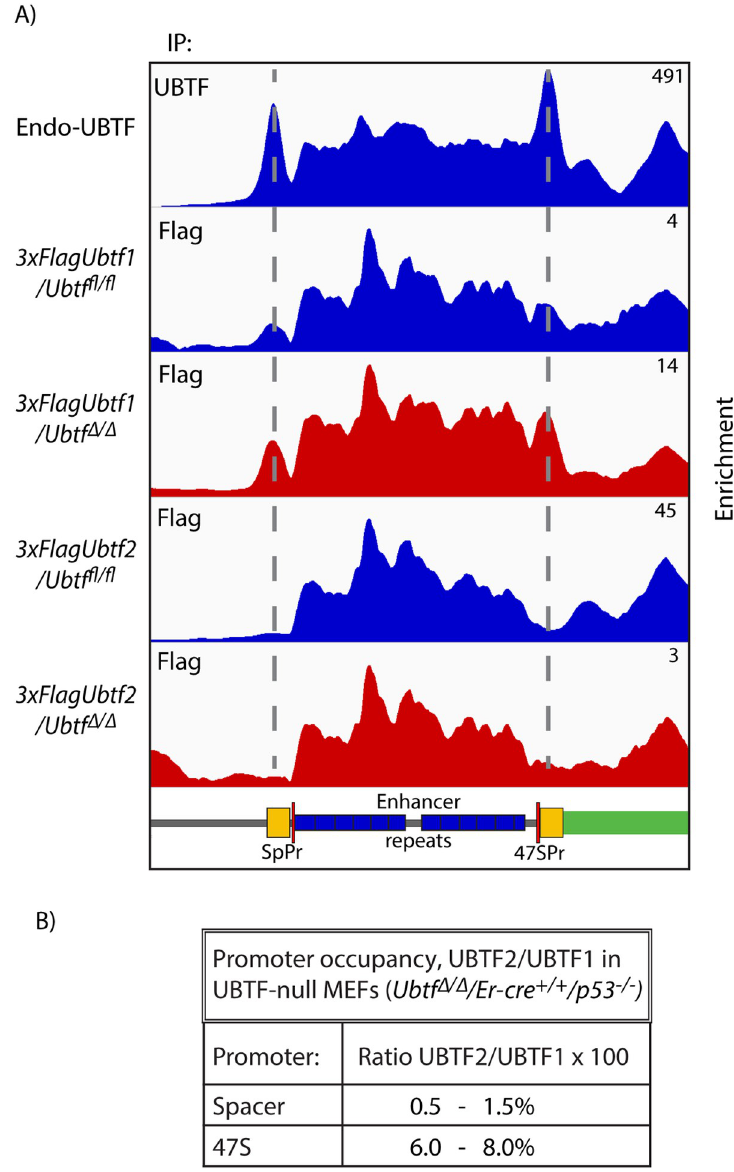
Fig 5. UBTF1 but not UBTF2 is recruited to the rDNA promoters in the absence of endogenous UBTF. A) DChIP-Seq mapping profiles of exogenous 3xFlag-tagged UBTF1 or UBTF2 in UBTF conditional ( Ubtf fl/fl /ER-Cre +/ + /p53 -/- ) MEFs before (blue) and after (red) UBTF deletion. As reference, the upper track shows mapping of the endogenous UBTF shown in Fig 3. B) Quantitation of UBTF1 and 2 at the Spacer and 47S promoters as determined by peak fit analysis, S12 Fig, see Materials and